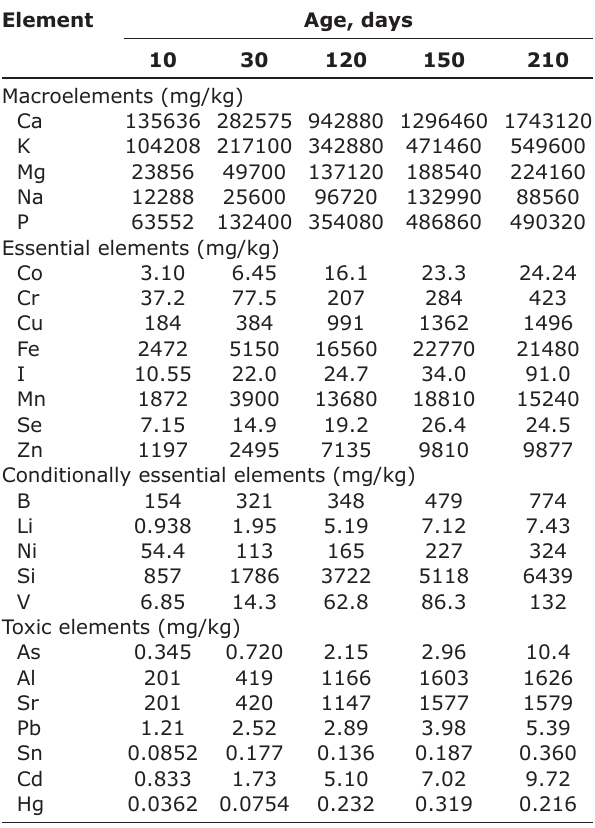
Table-1: Content of chemical elements in native substance of diet of laying hens at different age periods.